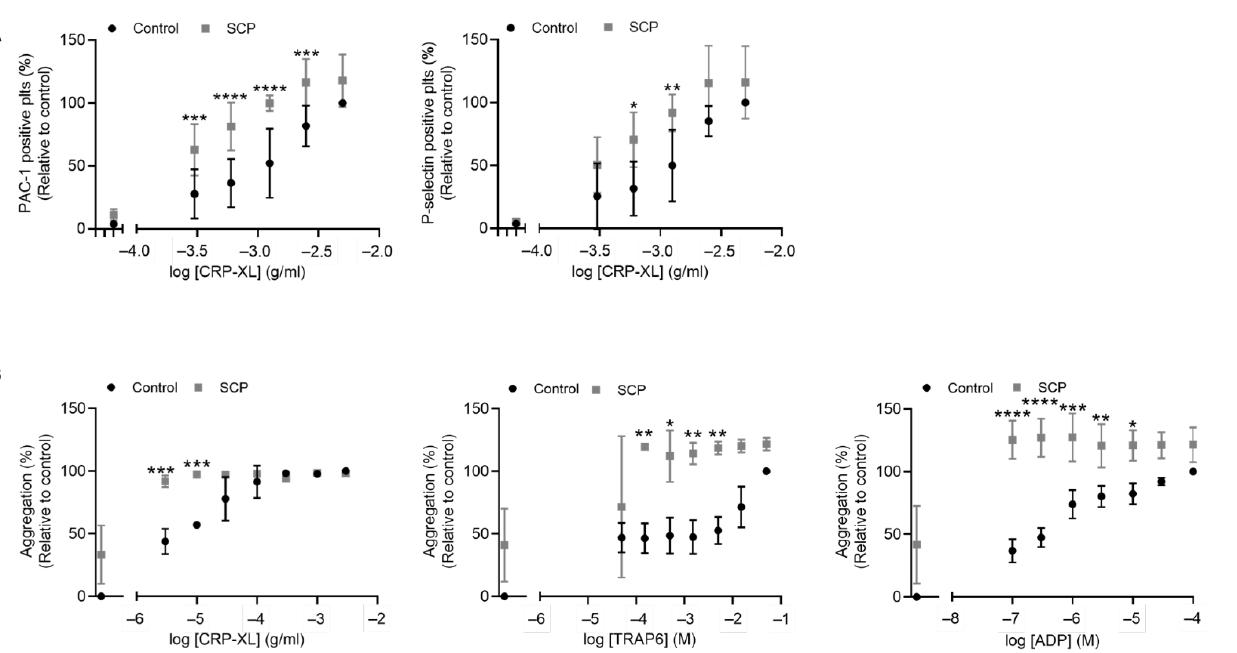
Figure 1. Coagulation-dependent activation of platelets independent of thrombin. ( A ) Washed human platelets in the presence or absence of supernatant of hirudin-treated, coagulated plasma (SCP) were stimulated with a range of CRP-XL concentrations. Activation of integrin α IIb β 3 and P-selectin expression were assessed by flow cytometric analysis, using FITC labeled PAC-1 mAb and Alexa Fluor (AF) 647-labeled anti-human CD62P mAb, respectively. Mean ± SD, n = 4. All data were scaled relative to aggregation obtained upon highest CRP-XL concentration in control condition (100%). Ordinary two-way ANOVA, * p < 0.05, ** p < 0.01, *** p < 0.001, **** p < 0.0001. ( B ) Aggregation of washed platelets in control or SCP induced by CRP-XL, TRAP-6 or ADP, as assessed by well plate-based aggregation method. Mean ± SD, n = 3. All data were scaled relative to aggregation obtained upon highest agonist concentration. in control condition (100%).